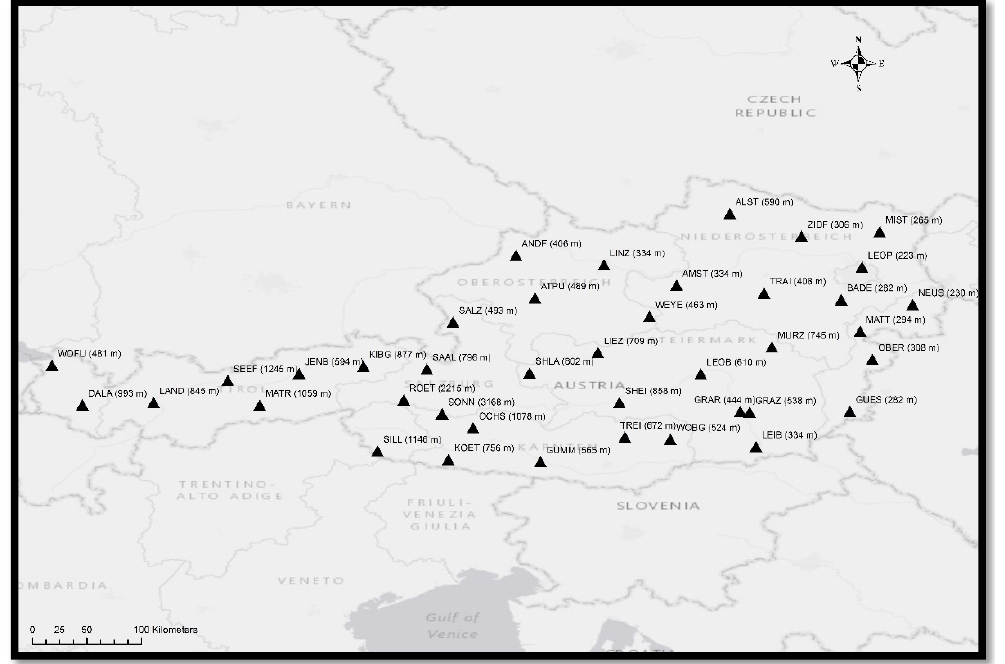
Figure 2. EPOSA Global Navigation Satellite System (GNSS) Network.